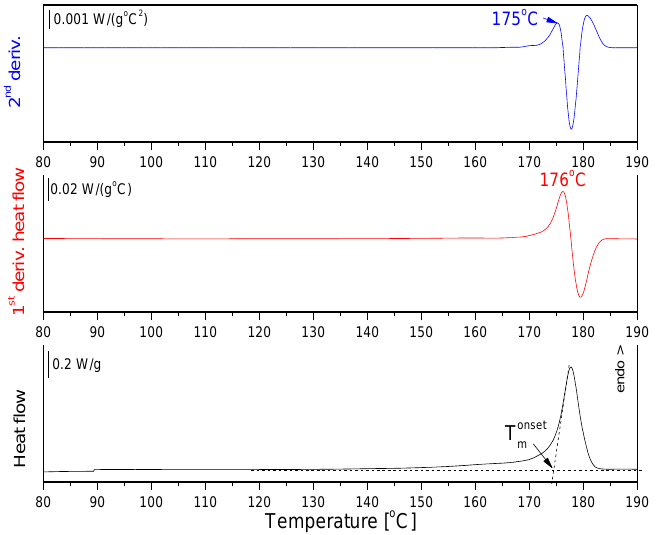
Figure 5. First heating differential scanning calorimetry (DSC) curve of PLLA_90 combined with the first and second derivative of the heat flow.